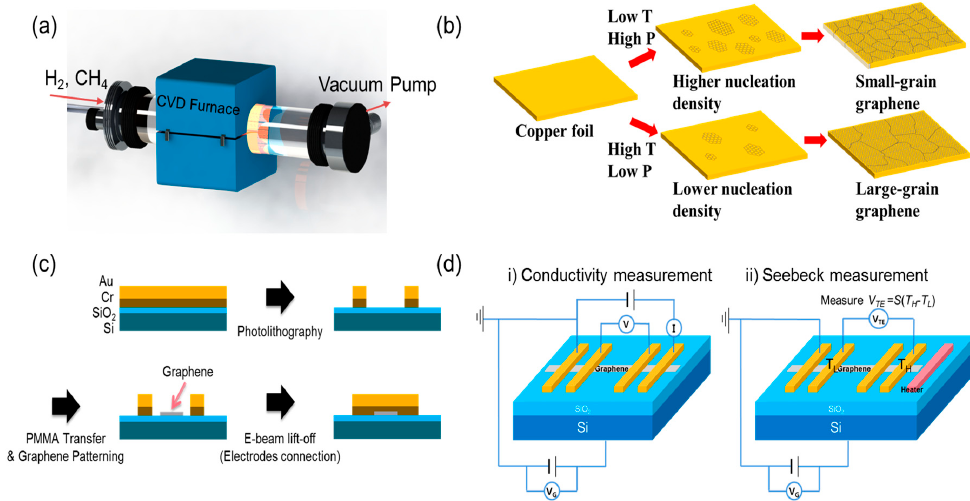
Figure 1. ( a ) Schematic of CVD graphene synthesis system, ( b ) grain size control by synthesis temperature and pressure variations, ( c ) fabrication process diagram for the Field Effect Transistor (FET) substrate with electrode/graphene sample laid down, and ( d ) schematic of the 4-point measurement layout.